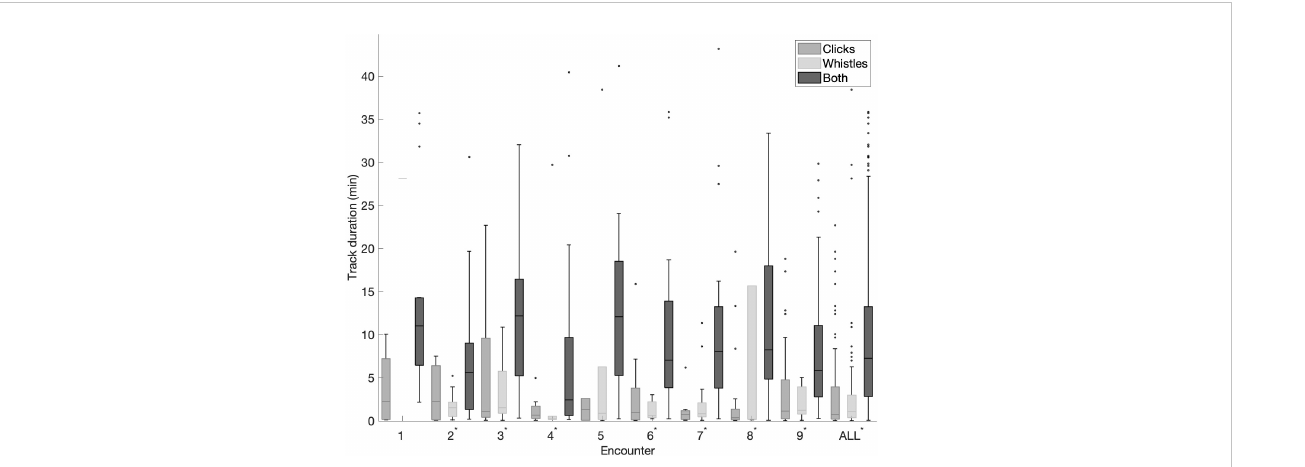
FIGURE 2 Track duration per encounter and for all encounters collectively. On each box the central line indicates the median, the bottom and top edges of the box indicate 25th and 75th percentiles, respectively. The whiskers extend to most extreme data points not considered outliers, and outliers are indicated as black dots. Note, some of the longer duration outliers are omitted for easier readability. Statistically signi fi cant results are denoted with an